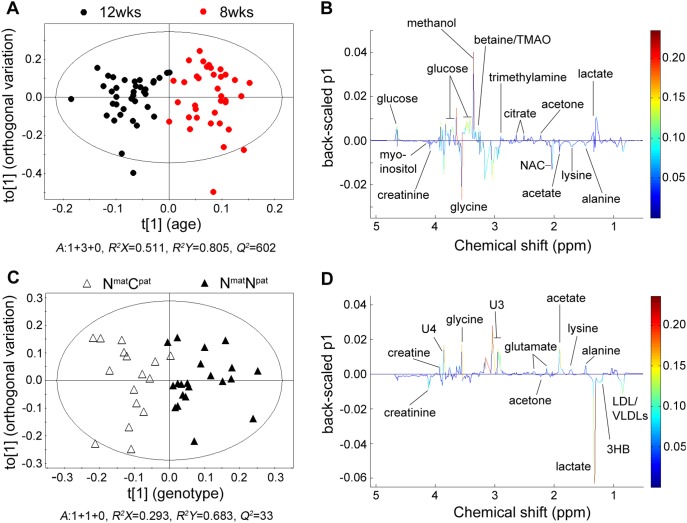
Orthogonal partial least squares – discriminant analysis (OPLS–DA) of lamb plasma metabolic profiles.Panel A: Scores plot of the comparison of plasma samples at 8 weeks (red dots) and 12 weeks (black dots) of age. Samples are separated by their age in dimension t[1], while the first orthogonal dimension to[1] contains orthogonal intra-group variation unrelated to age. Panel C: Scores plot of the comparison of plasma samples from NmatNpat (triangles) and NmatCpat (open triangles) lambs at 12 weeks of age. Samples are separated by genotype in dimension t[1], while the first orthogonal dimension to[1] contains intra-group variation unrelated to genotype. Panels B and D: corresponding 1D back-scaled loadings plots (0.5–5.1 ppm) for panels A and C, respectively, with the identity of several metabolites annotated. Weights of variables are shown by the colour scale. 3HB, 3-hydroxybutyrate; NAC, N-acetyl glycoproteins; TMAO, trimethylamine N-oxide; U3/U4, unknown metabolites 3/4.